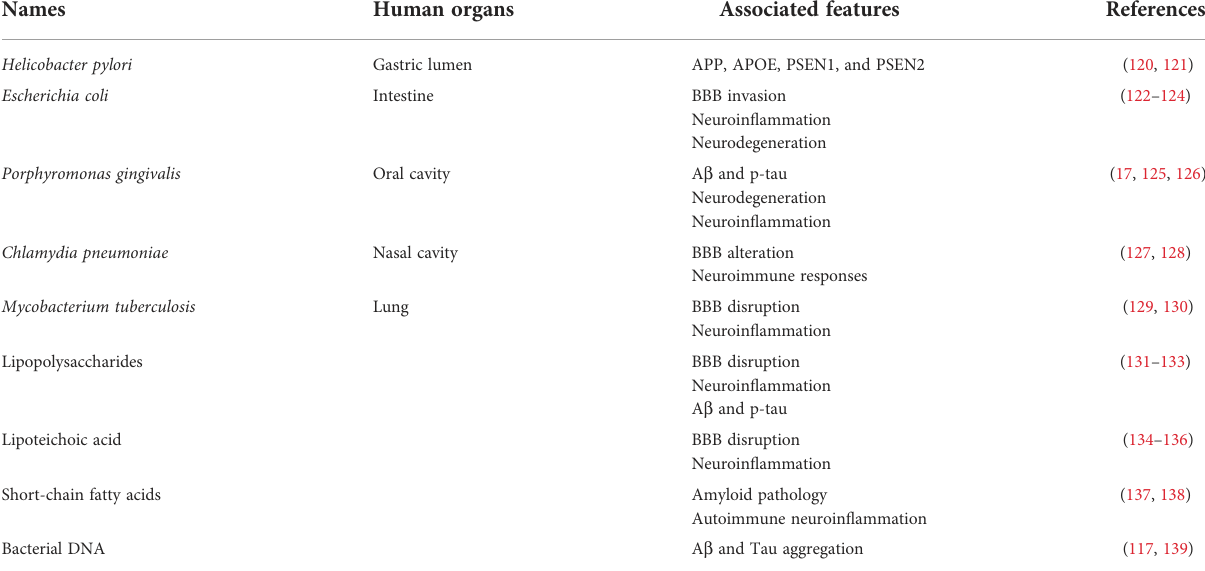
TABLE 1 Association of bacterial infection and neurological disorders.